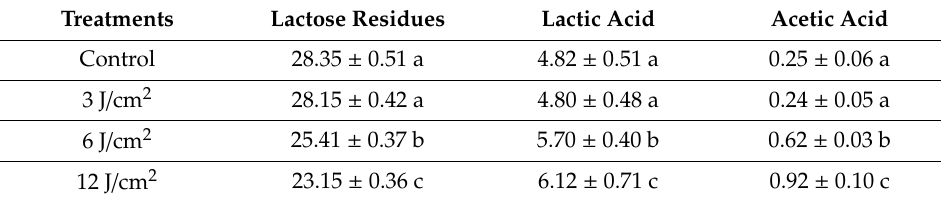
Table 1. E ff ect of red laser beam on lactose fermentation profile (mg / mL) by L. casei Table 1. Effect of red laser beam on lactose fermentation profile (mg/mL) by L . casei. Treatments